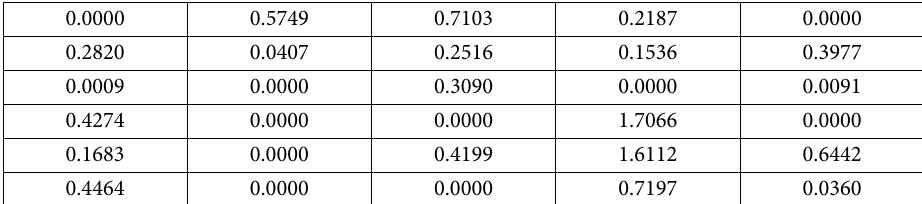
Table 11. The NDAS matrix